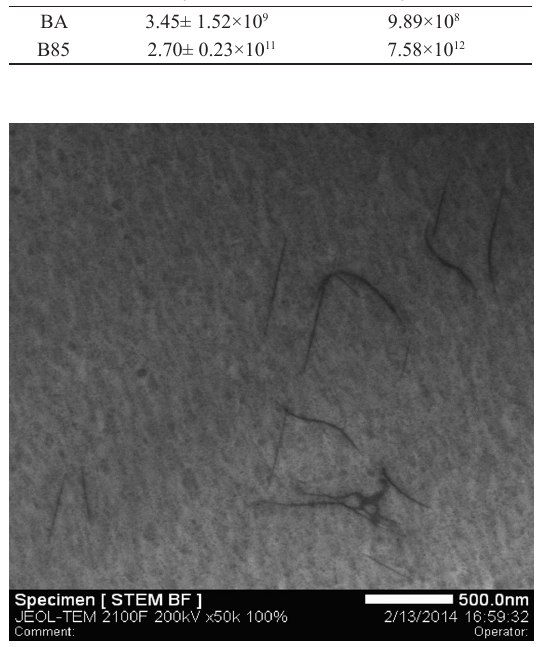
Figure 1. STEM micrograph from BA sample.